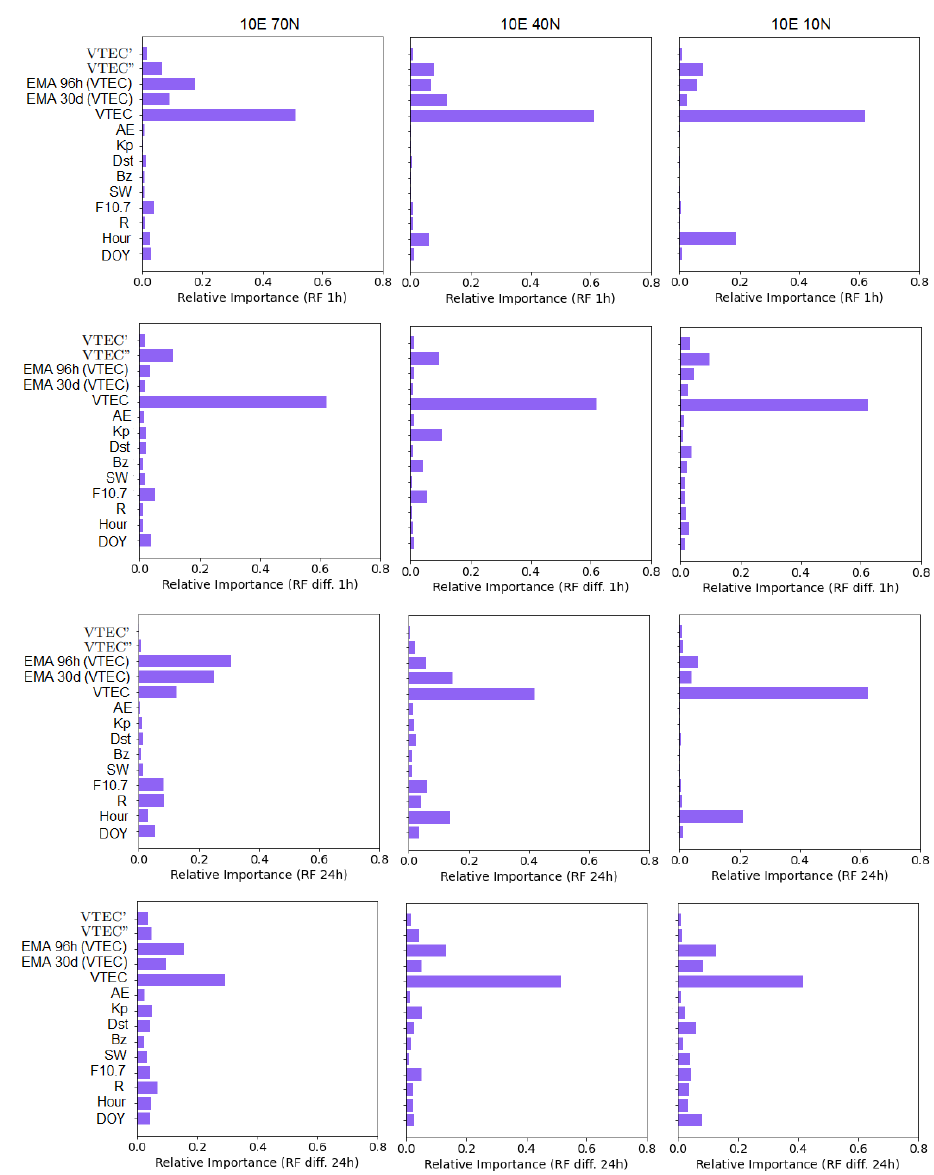
Figure 11. Relative importance of input variables to VTEC forecast for geomagnetic storm conditions (Kp ≥ 5) estimated from the Random Forest models. Results are presented for 1 h forecast with non-differenced data ( first row ) and differenced data ( second row ), and for 24 h forecast with non- differenced data ( third row ) and differenced data ( fourth row ) for high-latitude ( left ), mid-latitude ( middle ) and low-latitude ( right )